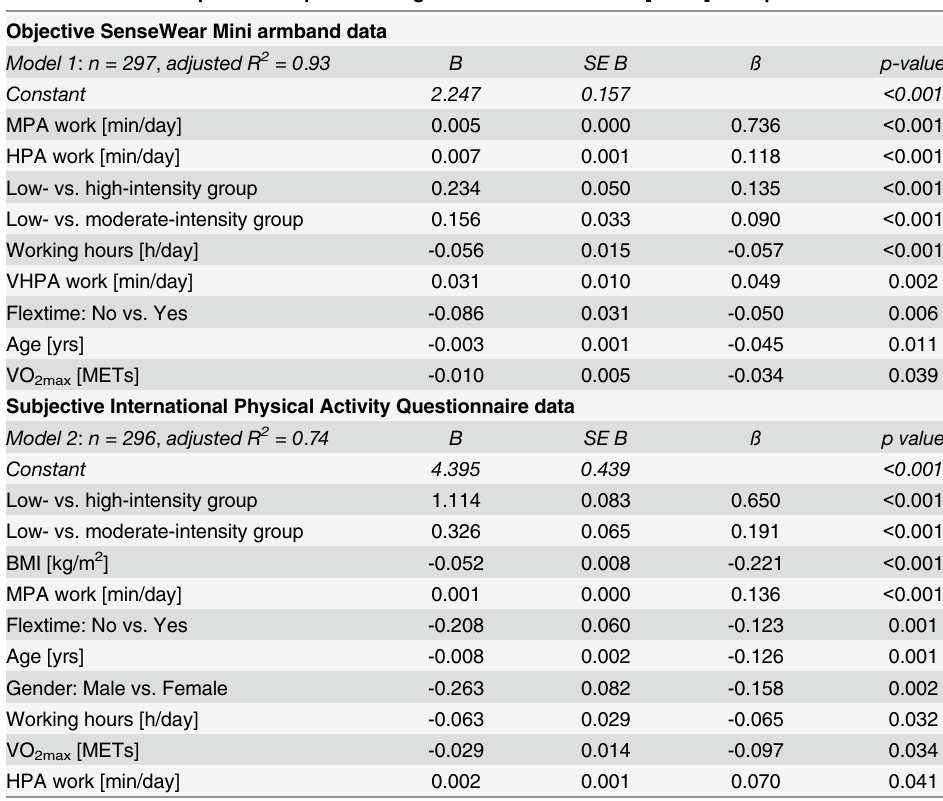
Table 3. Forward stepwise multiple linear regressions with workload [METs] as dependent